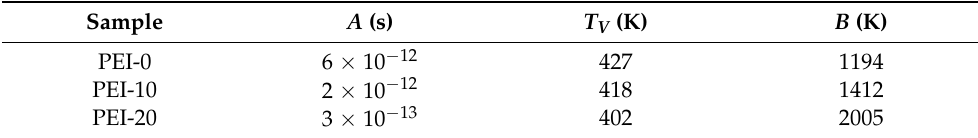
Table 3. Parameters of the VFT equation for the segmental α